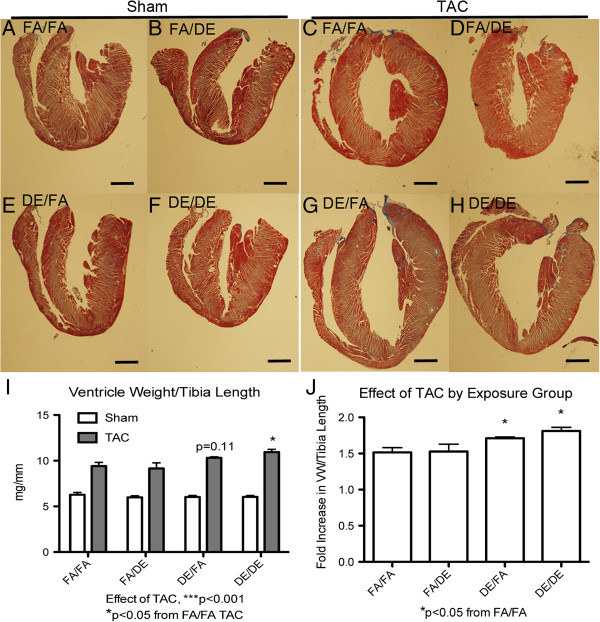
Gravimetric analysis of ventricle weight at necropsy. Representative images of sagittal sections of hearts from mice three weeks post sham or transverse aortic constriction (TAC) surgeries (A-H), scale bar = 1 mm. Gravimetric analysis of ventricles normalized to tibia length (VW/tibia length) in FA/FA (n = 7 sham, n = 8 TAC), FA/DE (n = 3 sham, n = 3 TAC), DE/FA (n = 5 sham, n = 5 TAC) and DE/DE (n = 5 sham, n = 4 TAC) groups (I). Effect of TAC by exposure group was also represented as a fold effect of TAC on VW/tibia length normalized to sham mice (J).